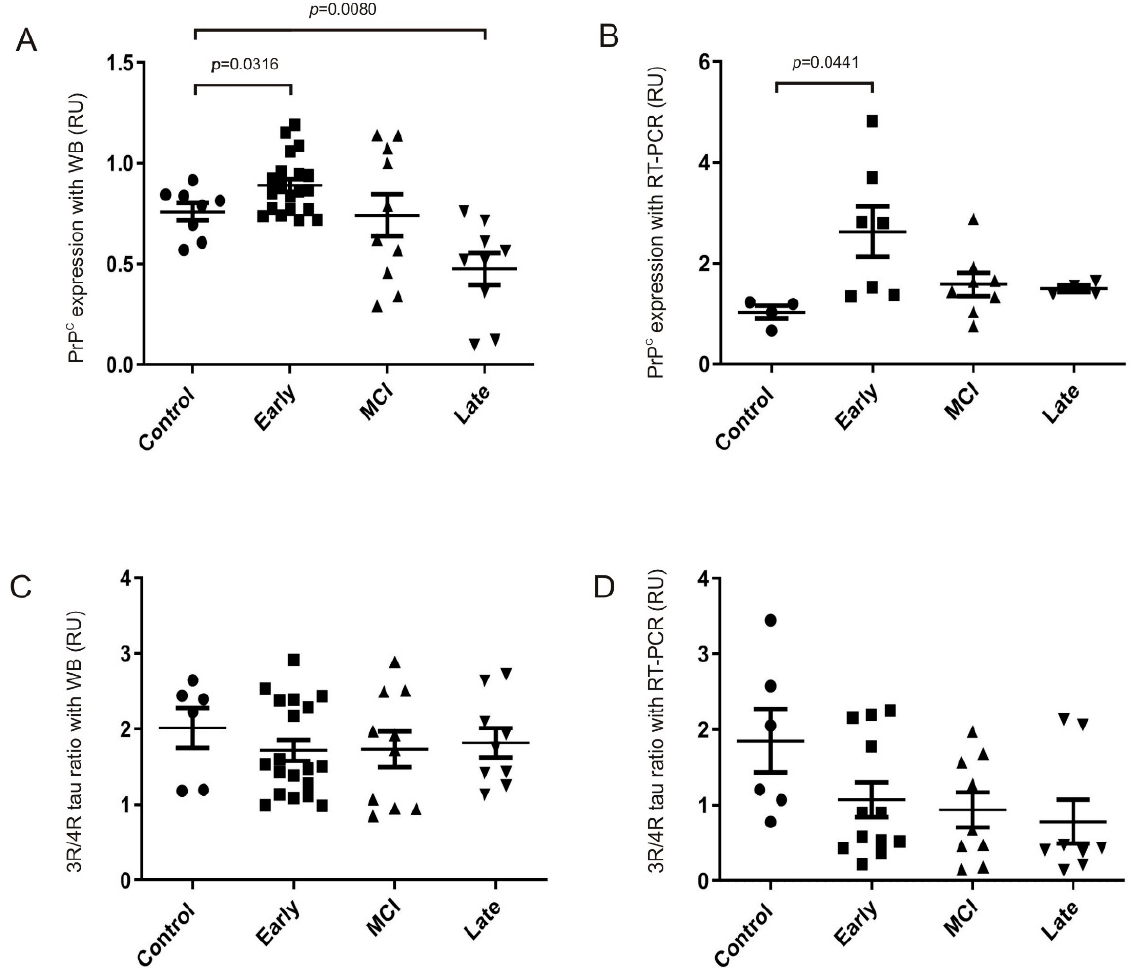
Figure 6. Expression of PrP C and splicing exon 10 isoforms of tau in AD brains according to Braak stage. ( A , B ) Plots illustrating PrP C expression by WB using anti-PrP C antibody (monoclonal 6H4). Actin detection was used as a control loading protein ( A ) or RT-PCR ( B ) in cases shown in Table 1 and grouped as Non-AD, Initial (Braak I-II), Intermediate (Braak III-IV), or Late AD (Braak V-VI). ( C , D ) Plots illustrating the ratio between 3R and 4R tau isoforms with WB analysis with RD3 and RD4 antibodies and using actin as control loading protein ( C ) or RT-PCR ( D ) in cases shown in Table 1. Each dot corresponds to one sample and the mean ± S.E.M. for each group is also